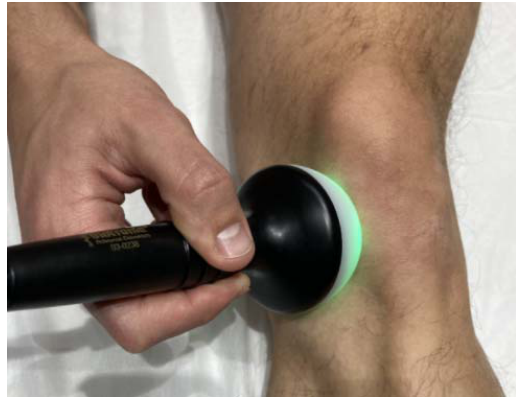
Figure 1. Application of MDR.